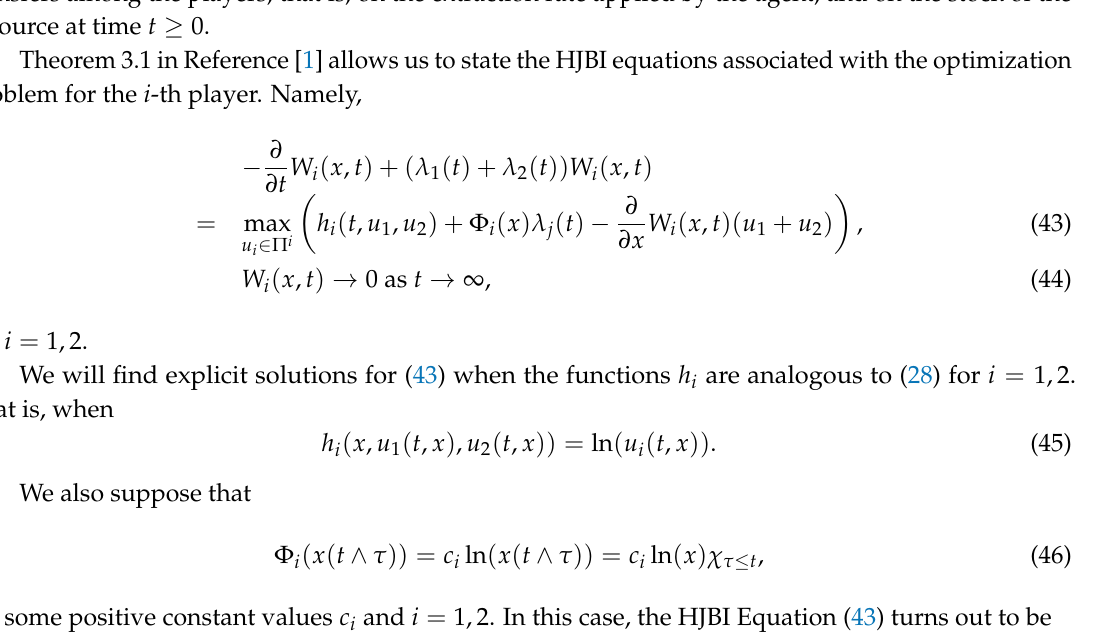
Figure 12. Ease of the extraction for Weibull (red) and Chen (blue) laws when δ 1 = 1 λ 1 = 1 = λ 2